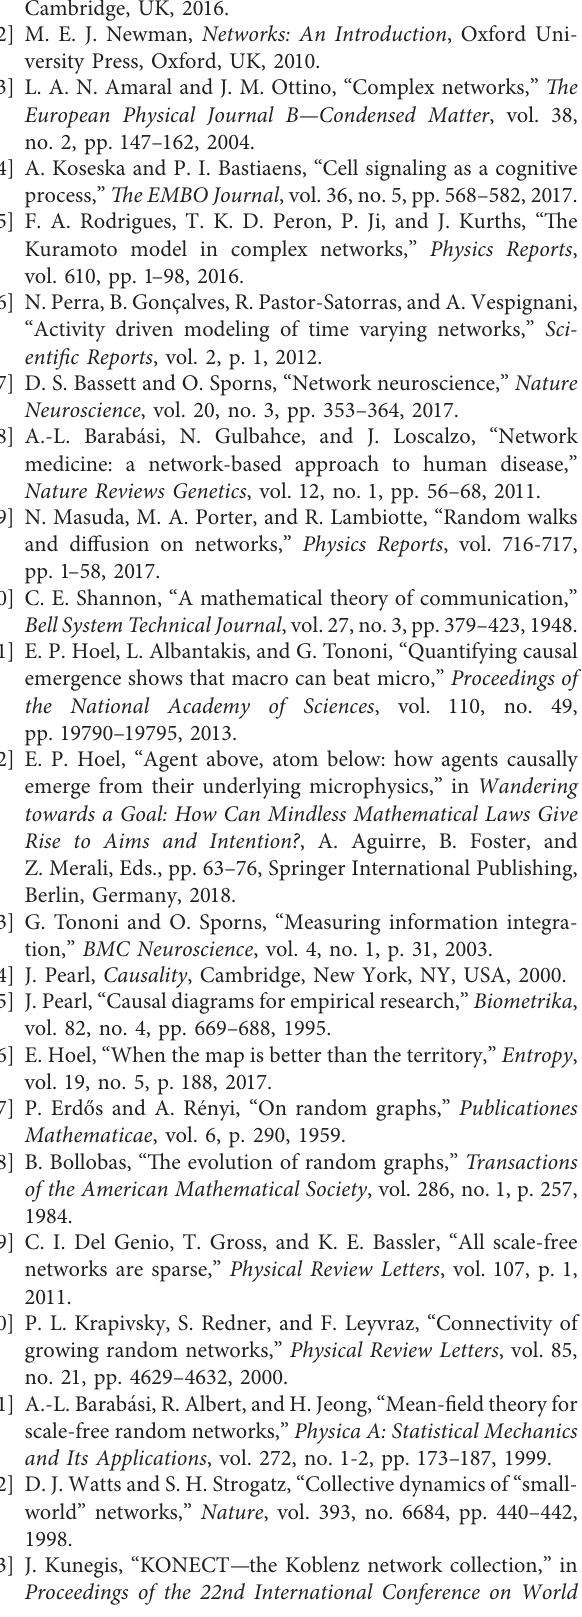
A: table of key terms. B: effective information calculation. C: deriving the effective information of common network structures. D: network motifs as causal relationships. E: table of network data. F: examples of consistent macronode. G: emergent subgraphs. ( Supplementary Materials